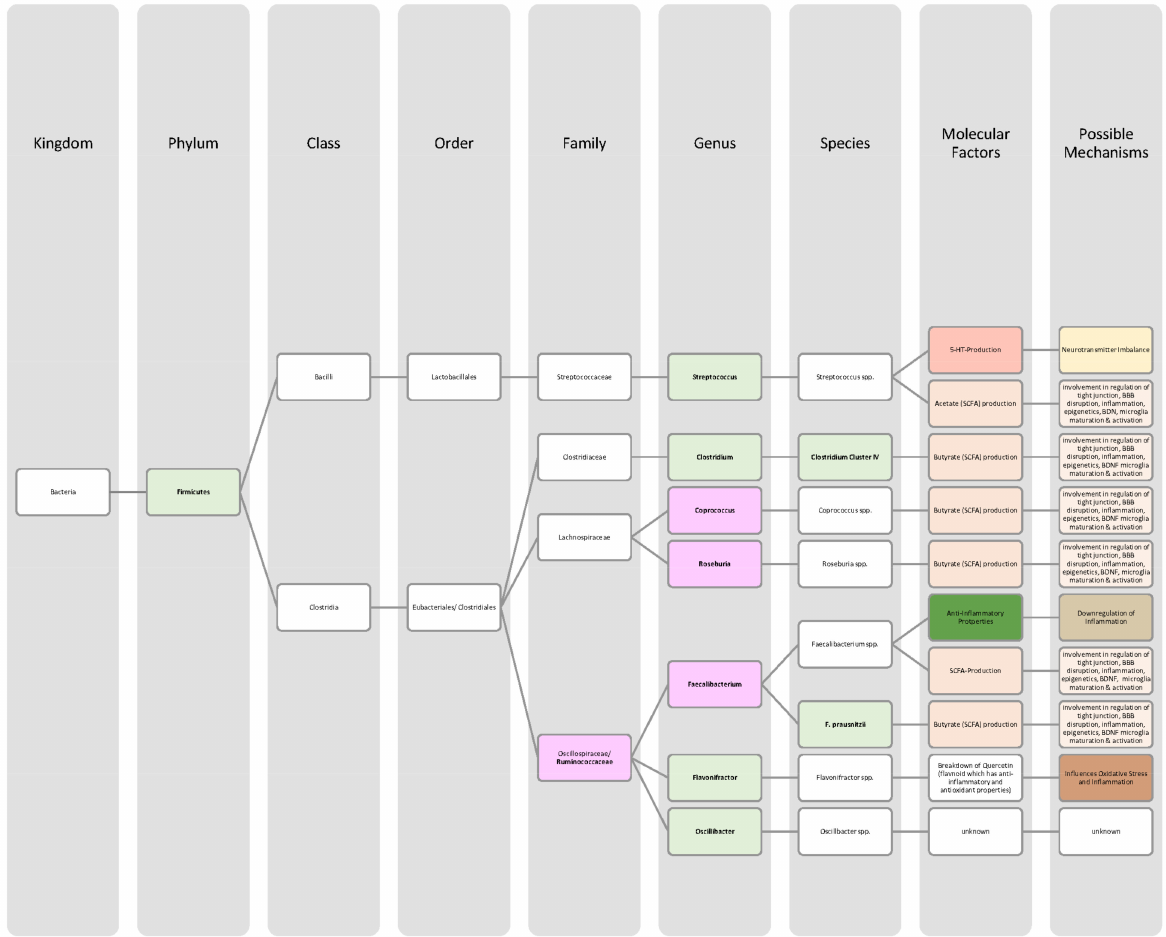
Figure 13. Part 2 of visual representation of the changes in microbiota composition in bipolar disorder (BD) patients from Table 8. For Figures 12 and 13: The pedigree design highlights the taxonomic classification of the dysbiotic bacteria. Light green cells stand for an increase and the light red cells for a decrease, respectively. Significant changes are shown in bold letters ( p < 0.05 or LDA values > 2). White cells indicate that no changes were reported or, in the case of phylum Bacteroidetes and genus Bacteroides, both significant increases and decreases were found. The last two columns contain additional, non-exhaustive information on how the bacteria are thought to impact the pathogenesis. The second last column to the right depicts bacterial molecular factors, which may be components of the bacteria or bacterial metabolites. Finally, the last column lists possible mechanisms by which these molecular factors may interfere with disease development. The colours summarise factors or mechanisms that are repetitive. Bacterial production or involvement in the metabolism of GABA (light blue, [18,20]), noradrenaline (light yellow, [18,20]), phenylalanine (dark orange, [27]), and 5-HT (salmon colour, [18,20]) may lead to an imbalance in central nervous system neurotransmitters (yellow) [100]. A reduction in Faecalibacterium spp., known for their anti-inflammatory properties (dark green), is associated with inflammatory mechanisms in BD (beige) [115,116,118]. Flavonifractor spp. can break down the flavonoid quercetin. Flavonoids are polyphenols and secondary metabolites of plants. They are known for their anti-inflammatory and antioxidant effects. The breakdown of quercetin through Flavonifractor could contribute to increasing oxidative stress and inflammation [115]. Gram-negative bacteria’s cell wall containing LPS (light purple) can stimulate TLRs located on immune cells (lilac, [21,31]). TLR-mediated immune activation is eventually leading to systemic inflammation, BBB disturbance, and neuroinflammation